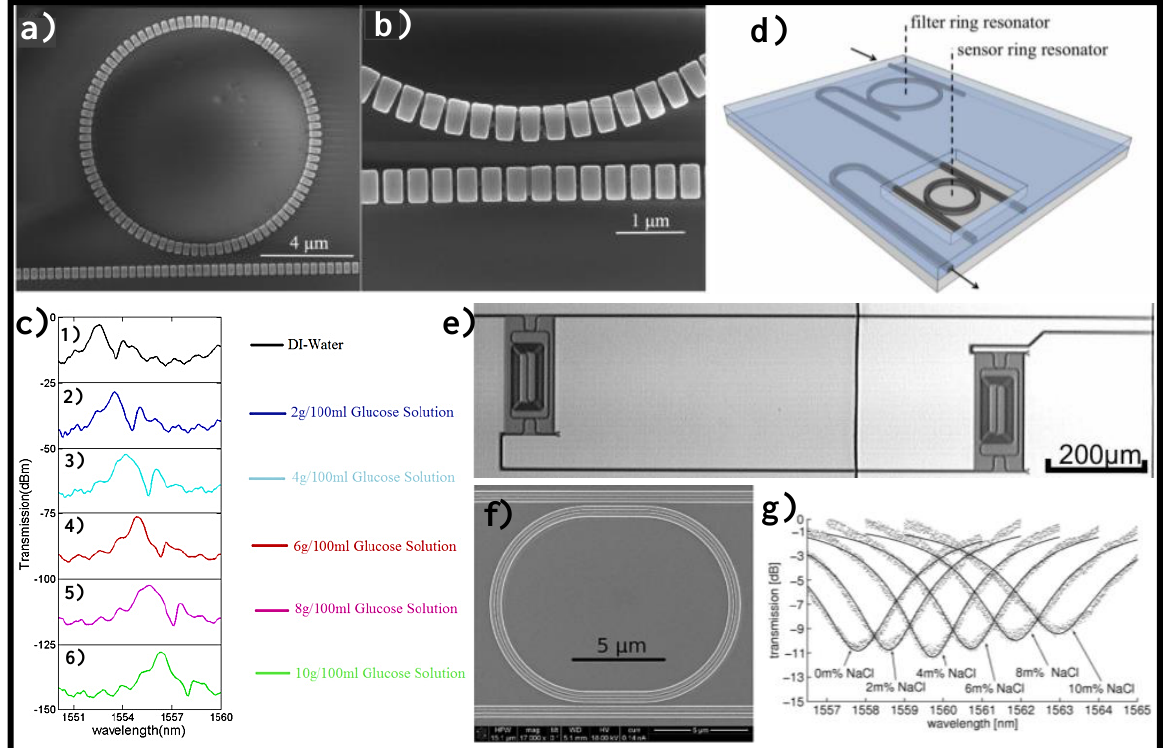
Figure 4. Recently proposed SOI-based RR sensing devices, ( a ) images of the manufactured SWG µ -RR device taken using a scanning electron microscope [52], ( b ) magnified picture of the gap region between the ring and bus WG [52], ( c ) experimental transmission spectra of the SWG µ -RR device submerged in deionized water and various glucose concentrations (1)–(6) [52], ( d ) a photonic sensing device made up of two cascaded RRs. Cascaded are two RRs with distinct optical roundtrip lengths. A thick cladding covers the whole chip, leaving only an aperture for one of the two RRs. The sensing device RR will be visible to changes in refractive index in its surroundings, but the filter RR will be insulated from these changes by the cladding [53]. ( e ) An optical microscope view of the SOI system. Two RRs with a physical roundtrip length of 2.5 mm are cascaded, and the cavity is folded to decrease the footprint. The entire device was coated in 500 nm silicon oxide, then the second RR was carved open [53]. ( f ) Top-view SEM image of the slot-WG-based RR, ( g ) for varied salt concentrations, the pass spectrum of the slot-WG-based RR shows a λ dip . The Lorentzian fits are presented in black, whereas the observed spectrum is shown in gray [57]. Table 1. Previously reported RR sensors and their sensing performance. Experiment/Simula- Waveguide Type S (nm/RIU) FOM Q-Factor Ref. tion Hybrid plasmonic Simulation